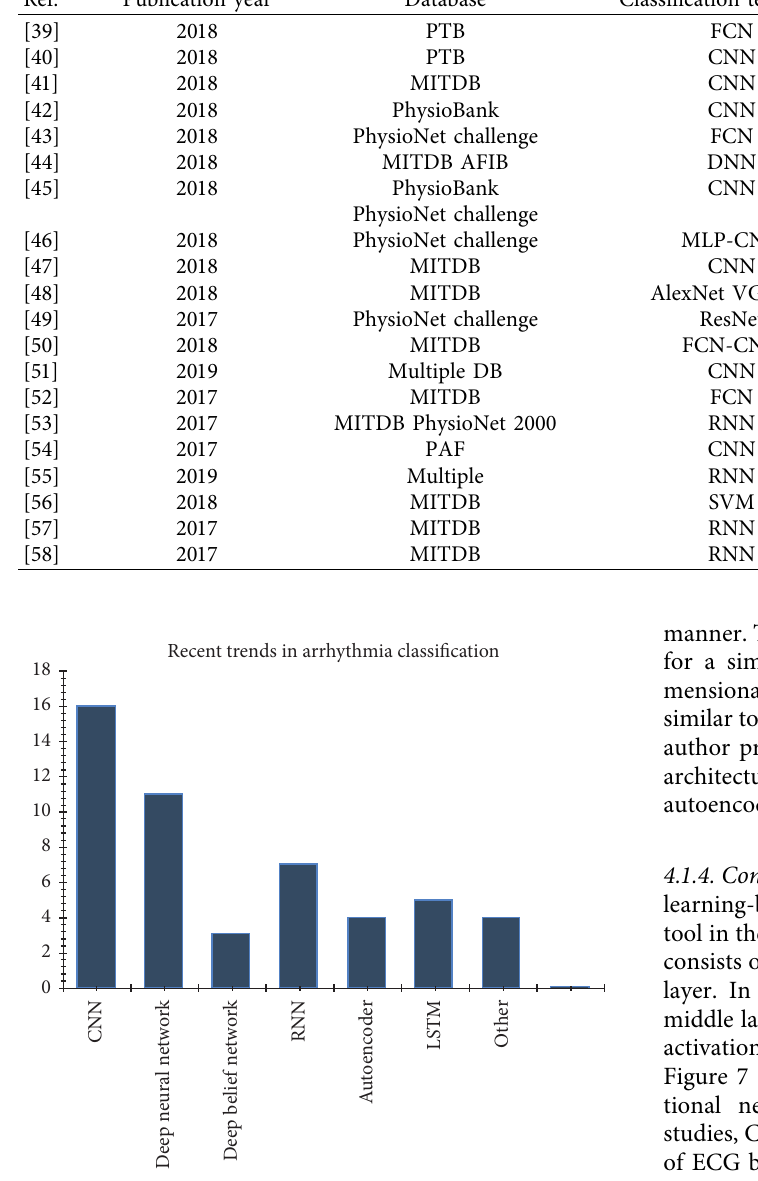
Figure 3: Arrhythmia classification techniques.